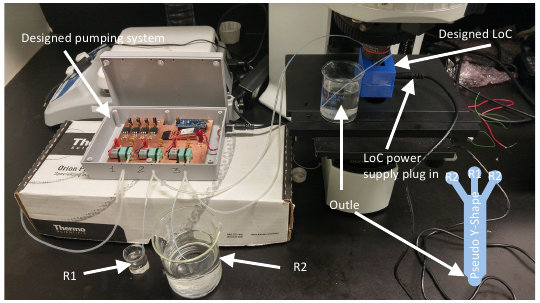
Figure 5. Experimental setup of the proposed LoC where reservoir (2) contains a mixture of sorbitan monolaurate, cholesterol and dicetyl phosphate dissolved in isopropyl alcohol (IPA) and (3)